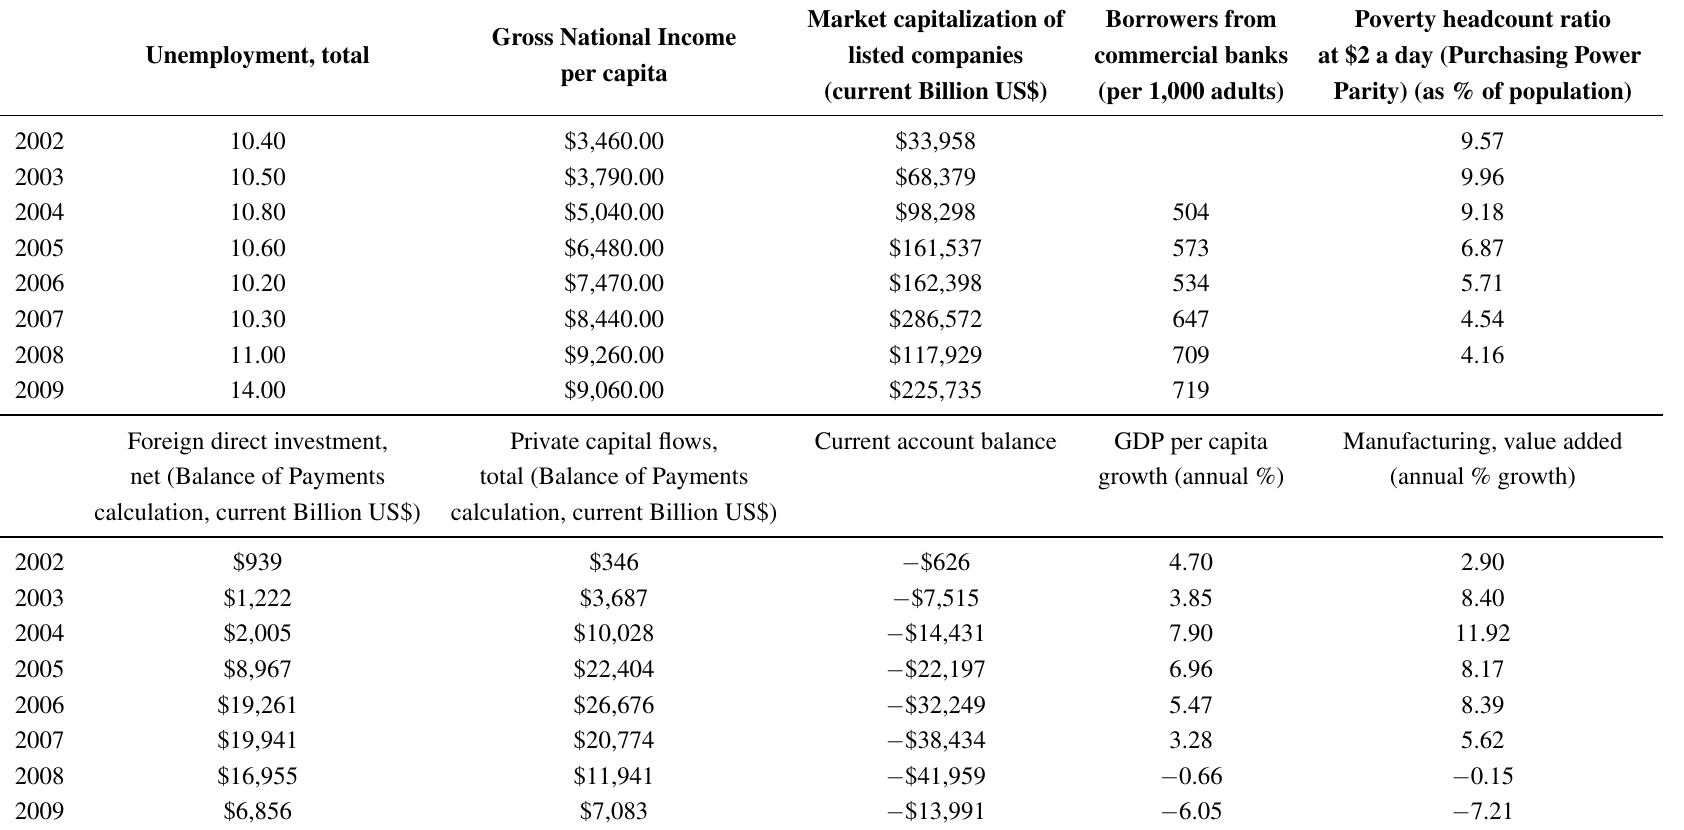
Table 1. Turkish Economic